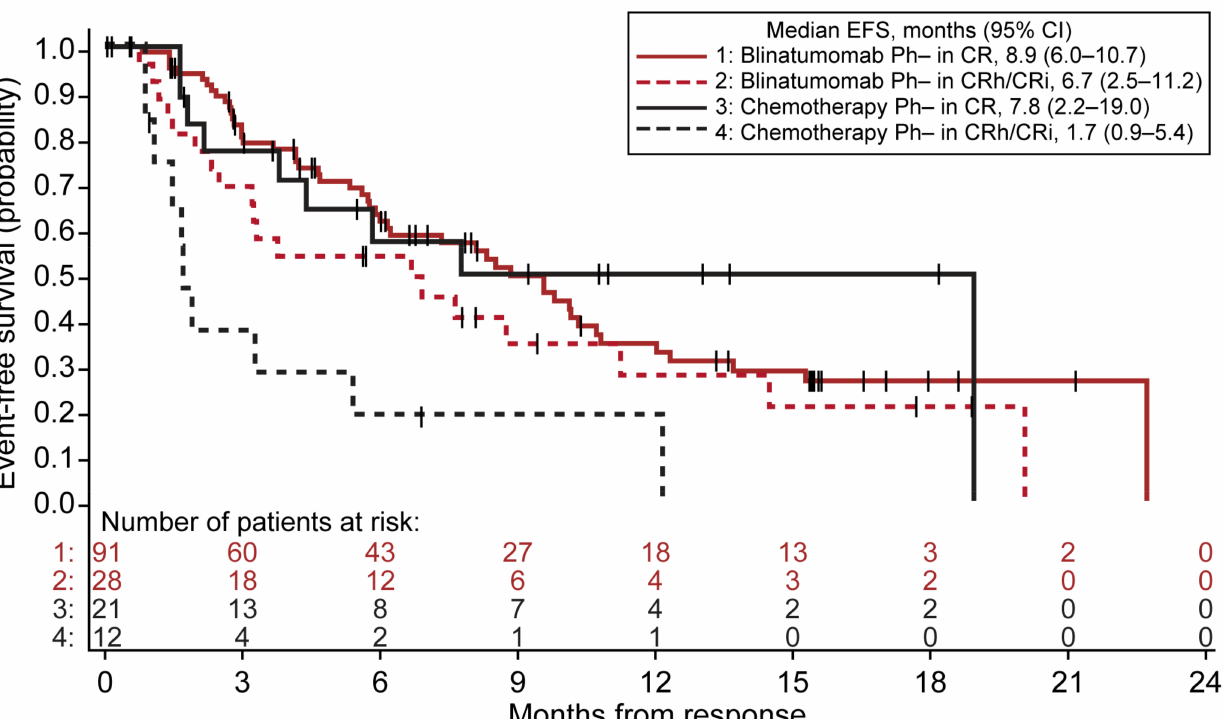
Figure 3. EFS analyzed according to the response within 12 weeks of treatment with blinatumomab or chemotherapy in the patients with Ph − R/R BCP ALL. ALL, acute lymphoblastic leukemia; BCP, B-cell precursor; CI, confidence interval; CR, complete remission; CRh, CR with partial recovery of peripheral blood counts; CRi, CR with incomplete recovery of peripheral blood counts; EFS, event-free survival; Ph − , Philadelphia chromosome-negative; R/R,